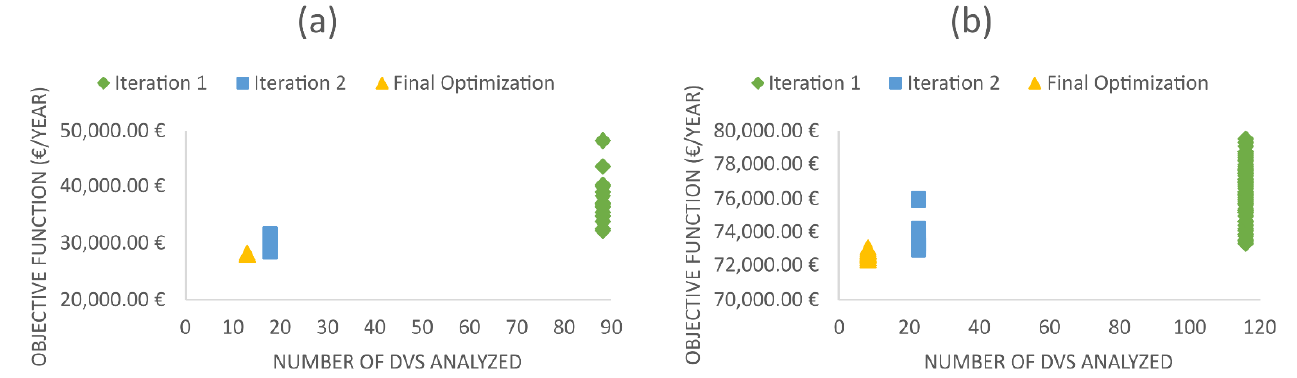
Figure 15. Results of the Objective Function in each iteration analyzed. ( a ) Balloon network. ( b ) ES- N network.